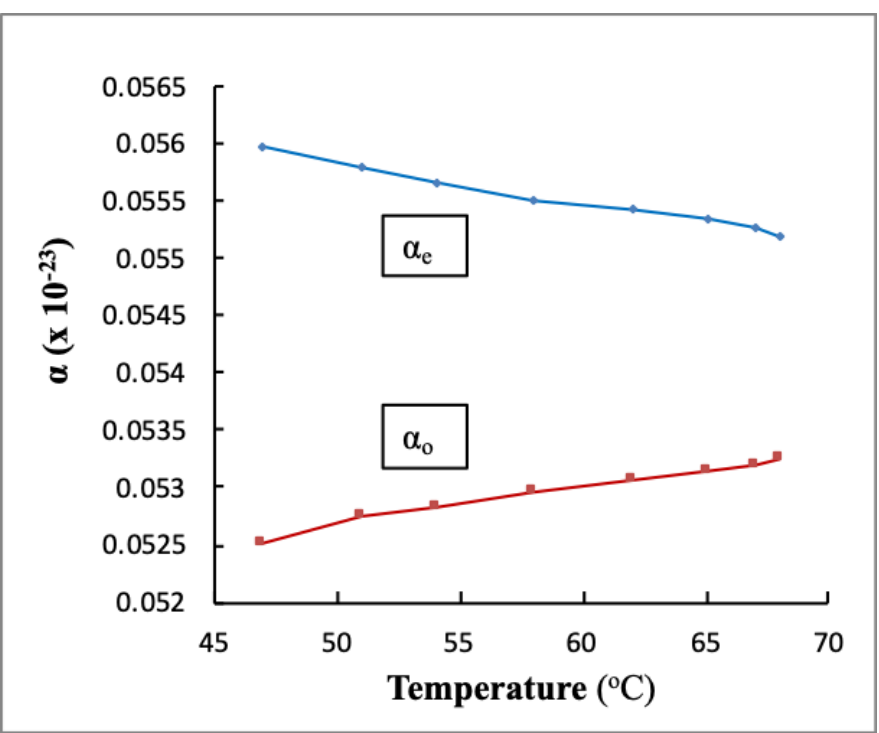
Figure 11. The relationship between the molecular polarizability and temperature for compound I .